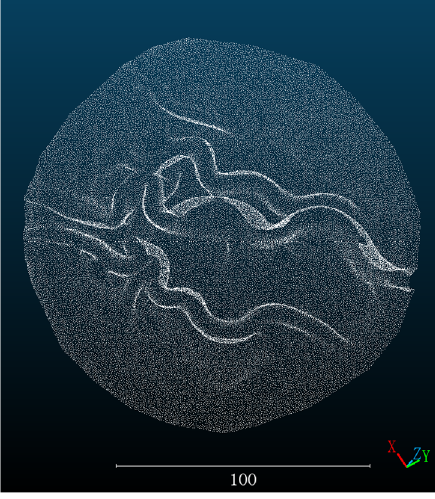
Figure 6. Ground truth value scanned by 3D Scanner.